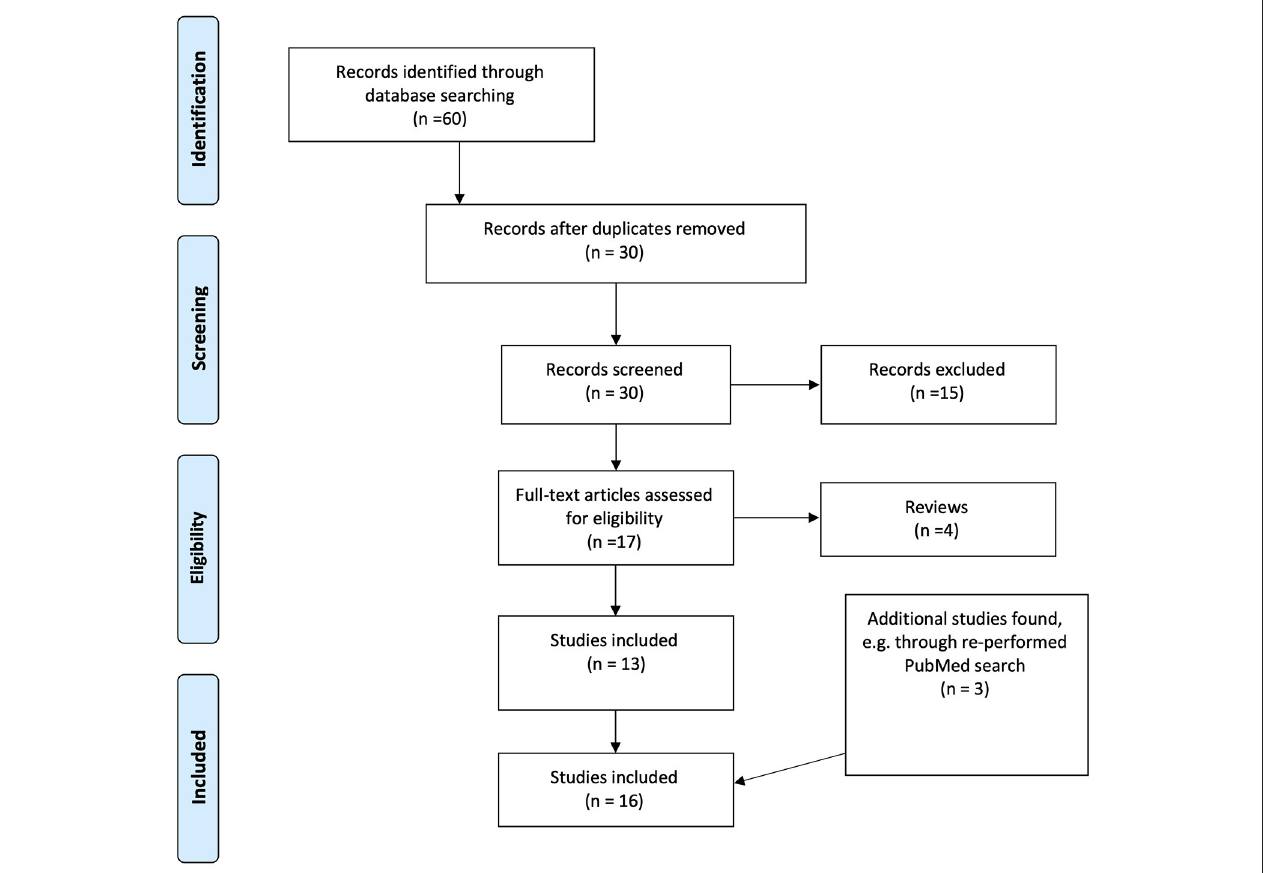
FIGURE 2 | Flow chart of the results of the literature search and inclusion process, based on the PRISMA flowchart.